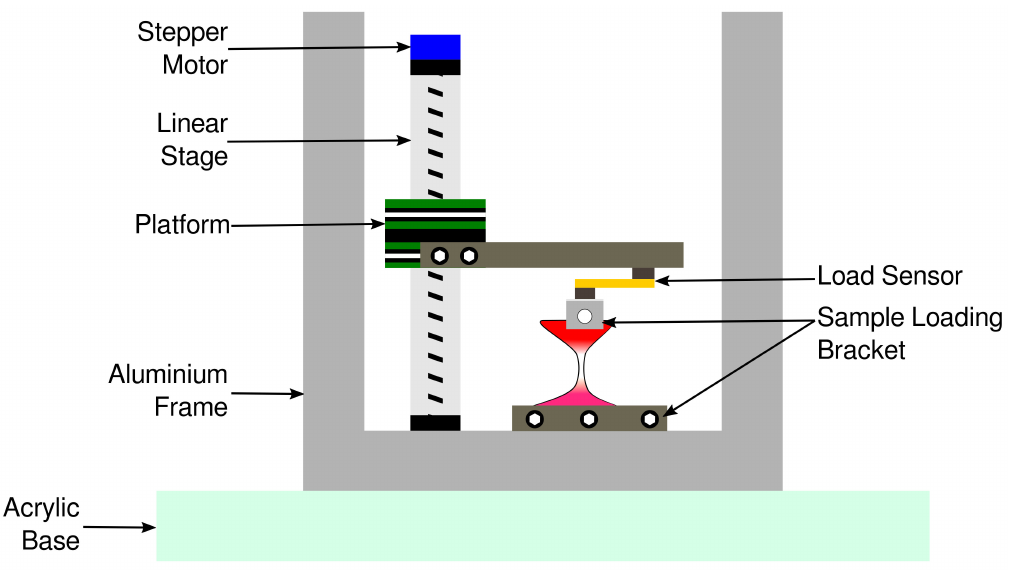
Figure 7. Sample strain apparatus. The stepper motor actuates the stage up to strain the samples loaded between the sample loading brackets. The aluminum frame is attached to a 1 / 8th inch clear acrylic sheet which acts as a door (not shown in the illustration) to load samples. The thick acrylic base is used to stabilize the rig during data acquisition and also for mounting the rig at the X-ray beamline on an XY sample